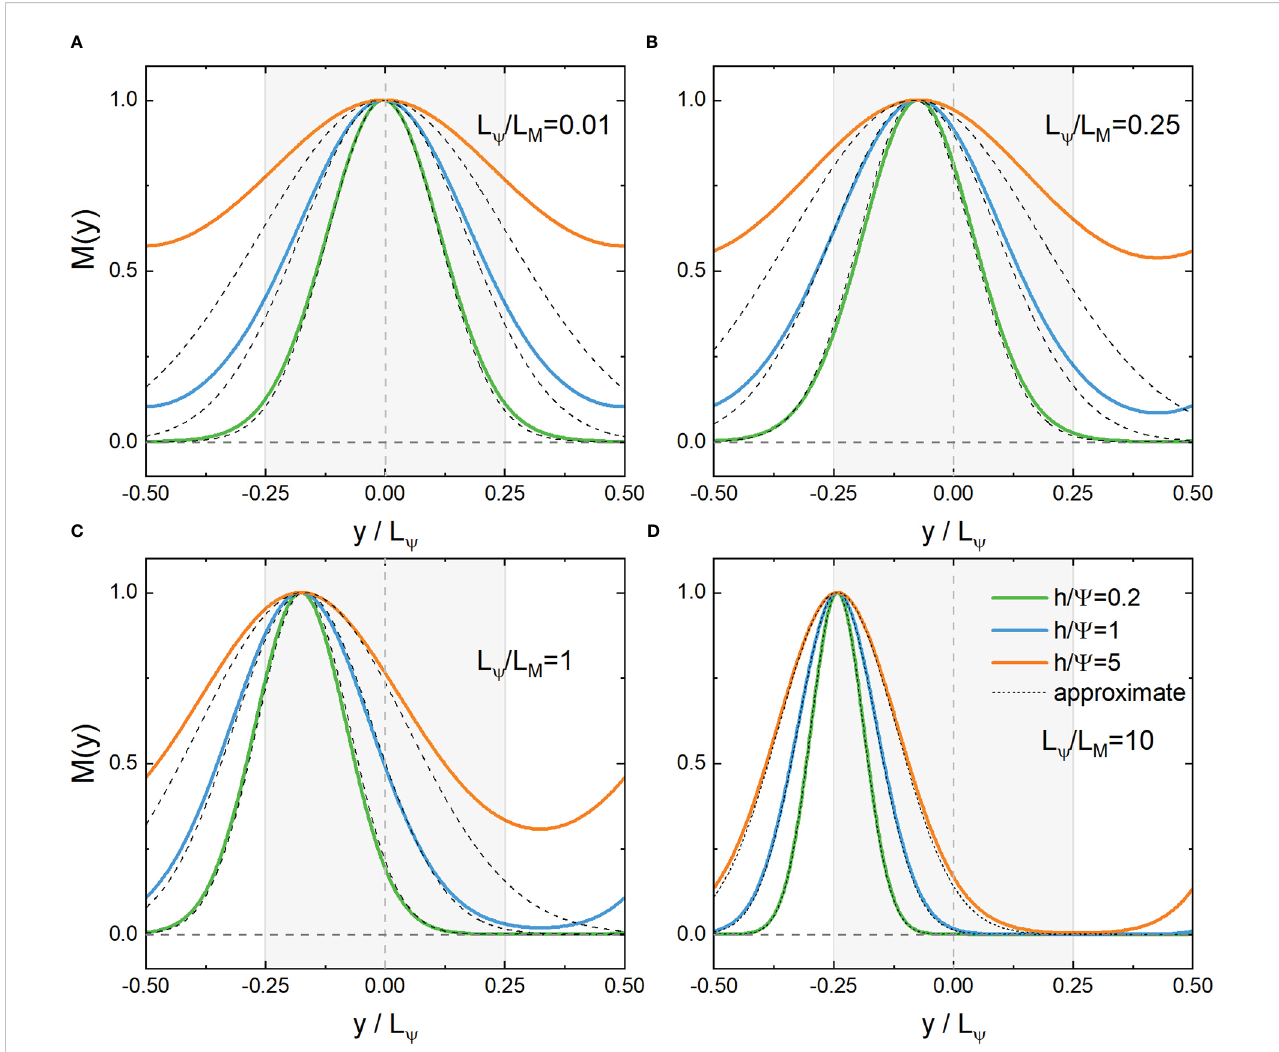
FIGURE 1 Distribution of the even eigenfunction M C ( w ′ , x , y ′ ) and its approximate solution near the core ( y =0) (A, B) or boundary ( y / L Y = − 1/4) (C, D) with the lowest eigenvalues. L y / L M = k x / k 0 =0.01,0.25,1,10, h = Y =